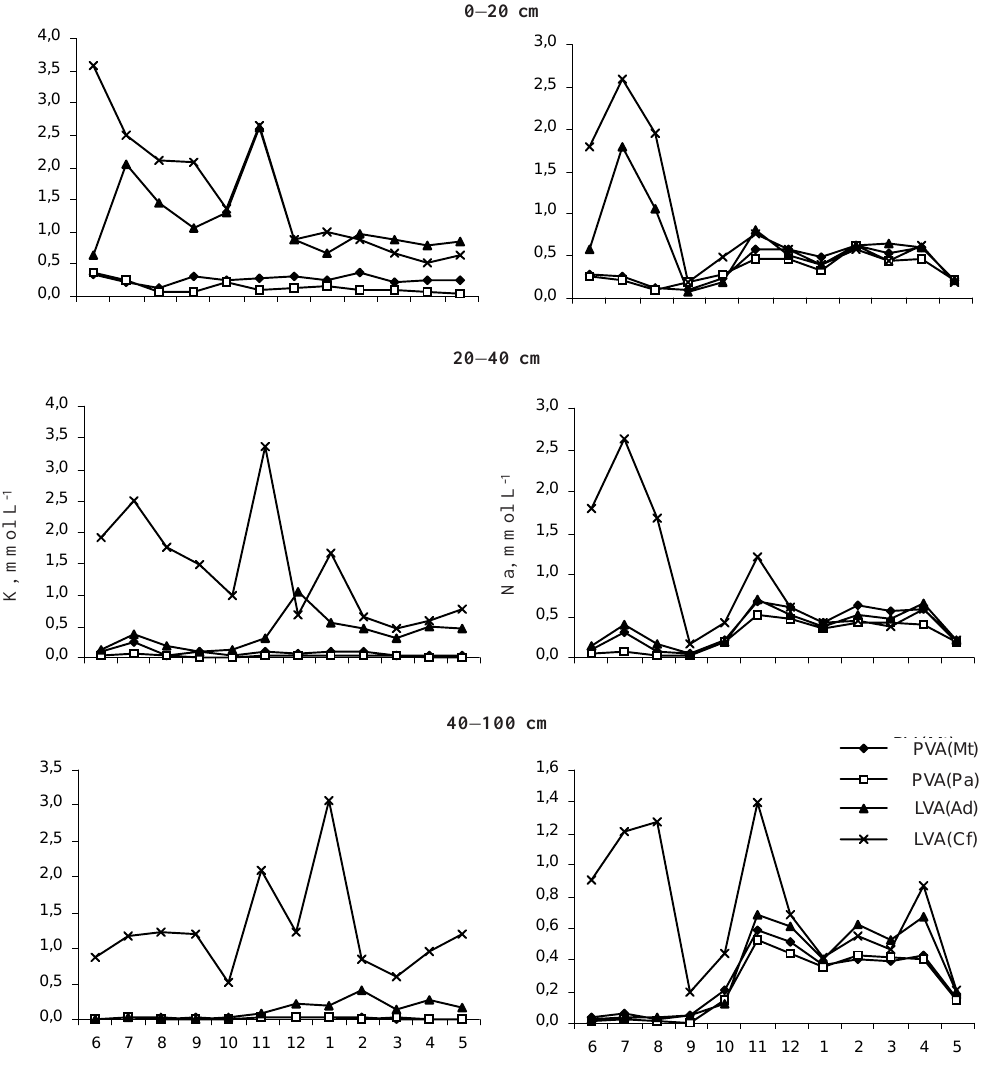
Figura 3. Variação mensal da concentração de potássio e de sódio na solução do Argissolo Câmbico sob mata (PVA(Mt)) e sob pastagem PVA(Pa) e do Latossolo Vermelho-Amarelo sem cobertura vegetal (LVA(Ad)) e sob cafeeiro (LVA(Cf)), no período de junho de 1996 a maio de 1997, em três profundidades. Média de três